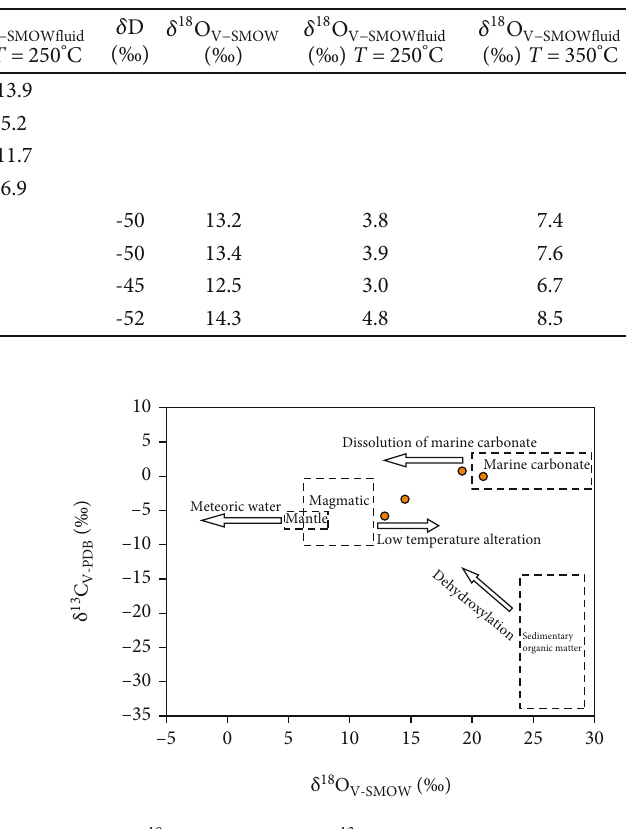
δ 13 C Figure 9: δ 18 O V − SMOW versus V − PDB diagram of carbonate from the Xinmin deposit (after